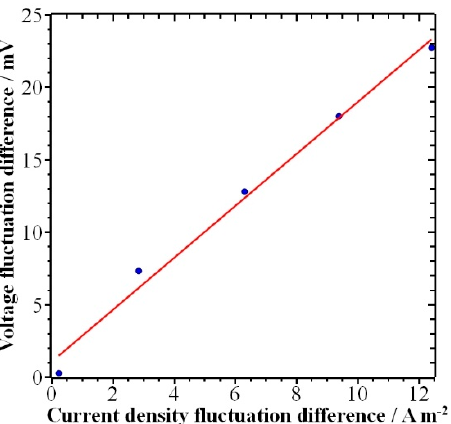
Figure 9. Relationship between voltage fluctuation difference and current density difference.